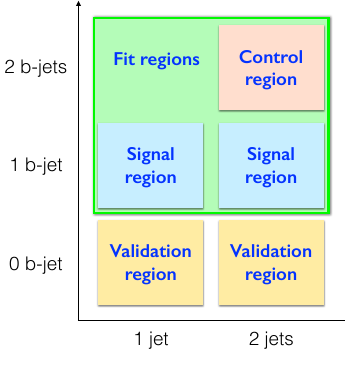
Figure 4. A schematic view of signal, control and validation regions. Signal and control regions are used in